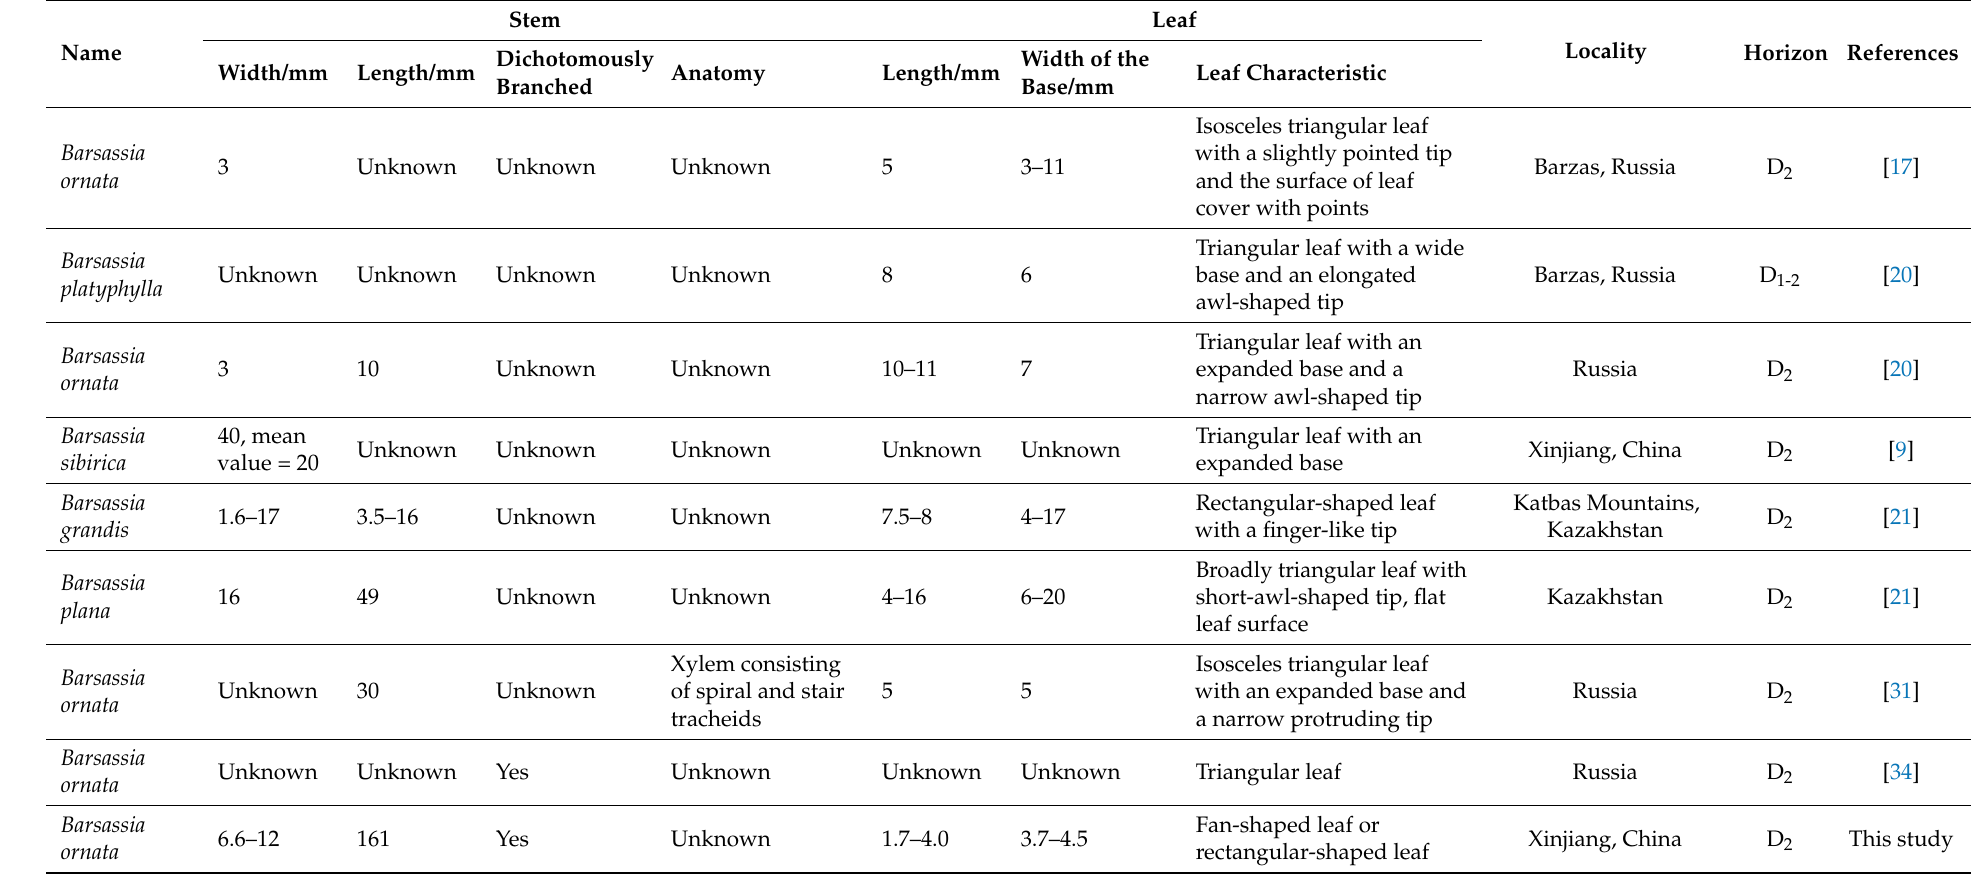
Table 1. Dimensions and characteristics of Barsassia ornata under different